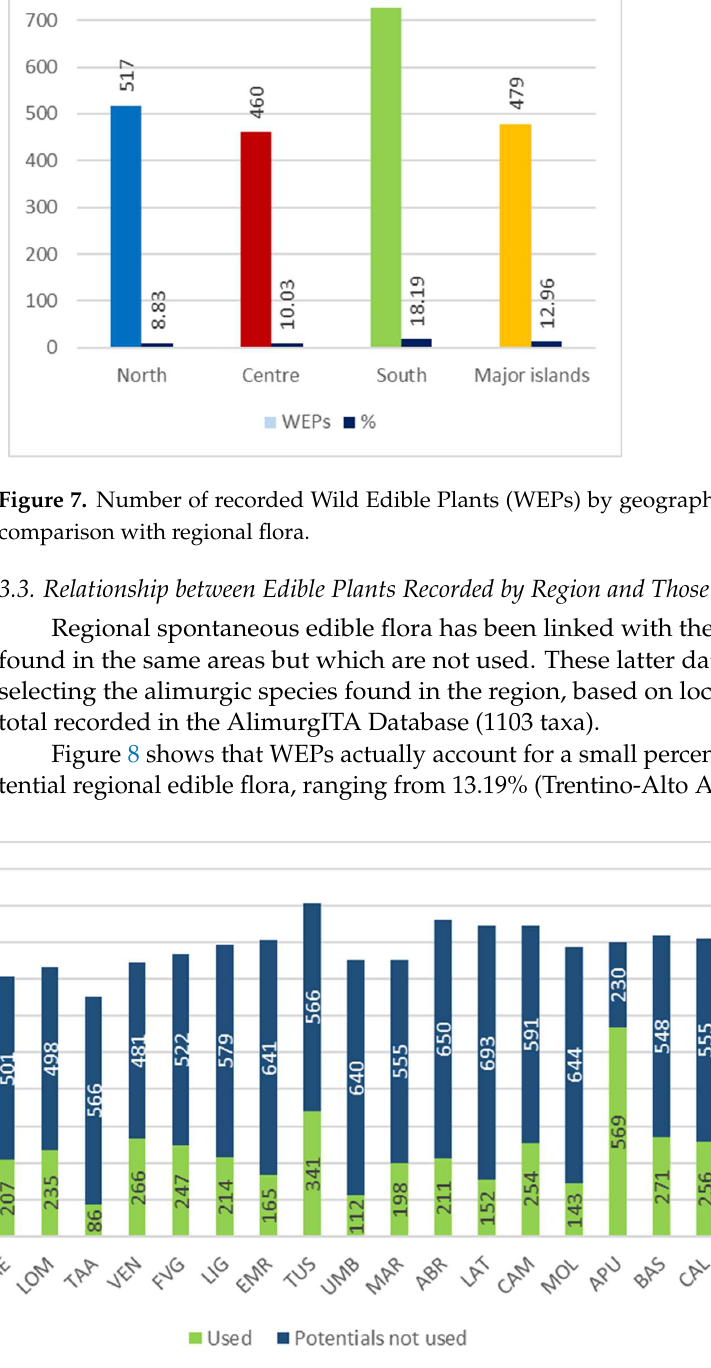
Table 5. Number of taxa excluded from the calculation of WEPs and reason for exclusion